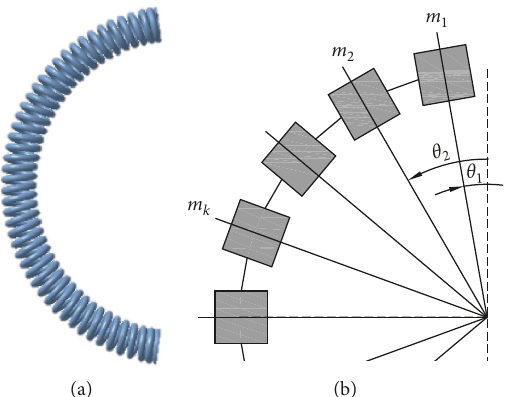
Figure 3: Structural diagram of (a) arc spring and (b) discrete element.